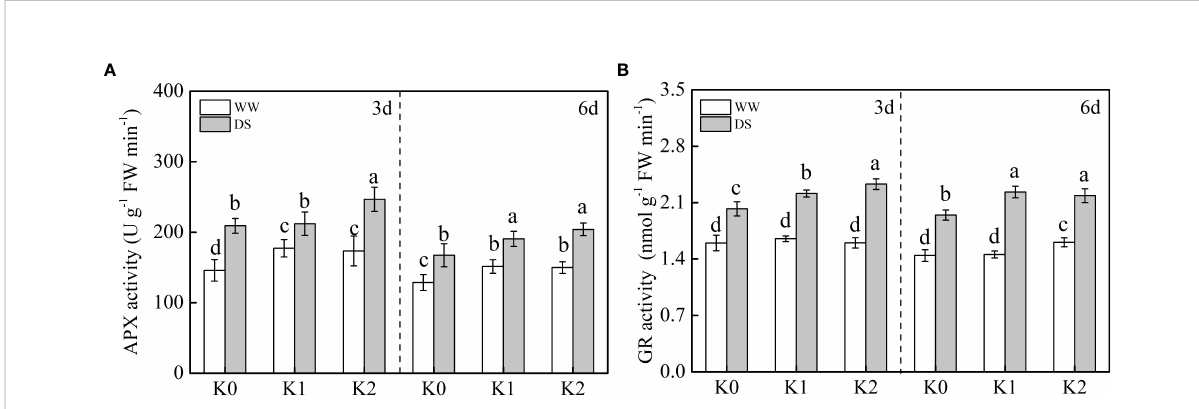
FIGURE 5 Effects of drought stress on the activities of APX (A) and GR (B) in sesame leaves at the fl owering stage under different K levels. K0, K1, and K2 represent K application rates at 0, 60, and 120 kg ha − 1 K 2 O, respectively. 3 d and 6 d indicate the sample date from the initiation of drought stress. Lowercase letters show signi fi cant differences at the P <0.05